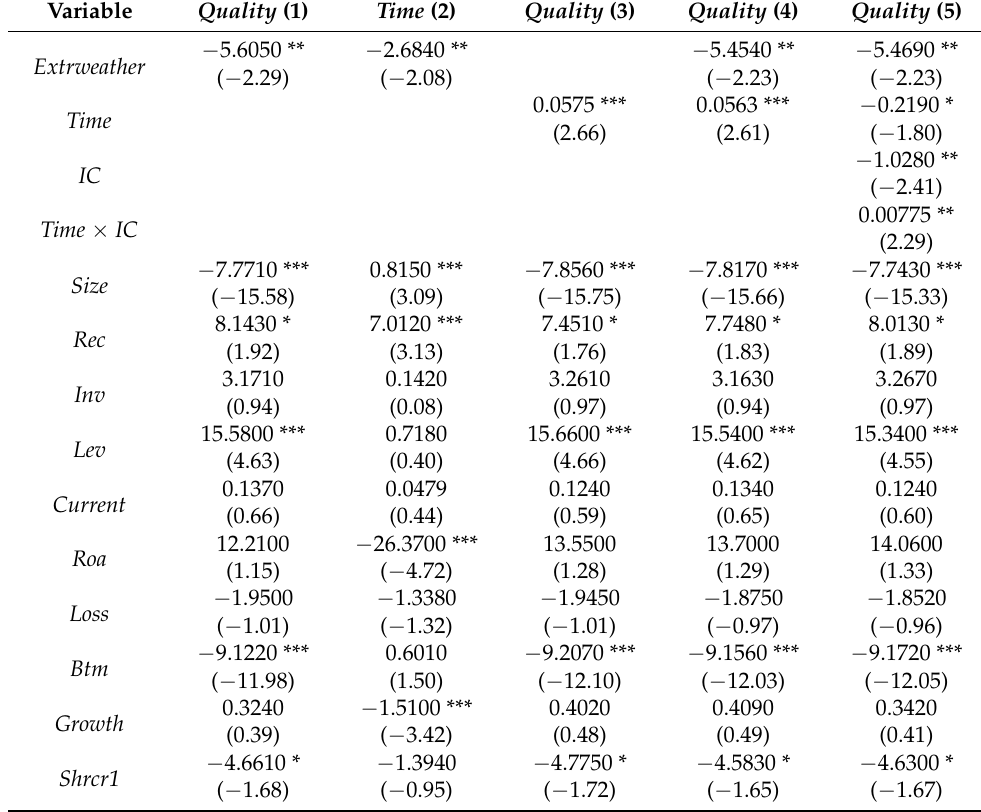
Table 5. Regression results using Extrweather